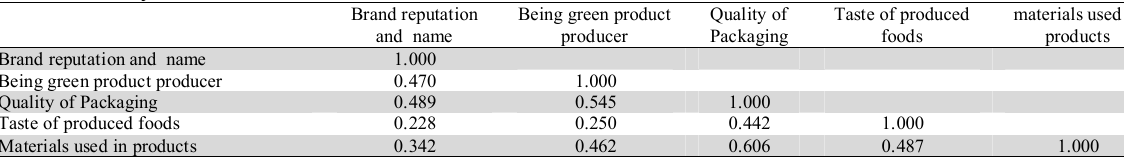
The summary of Pearson correlation